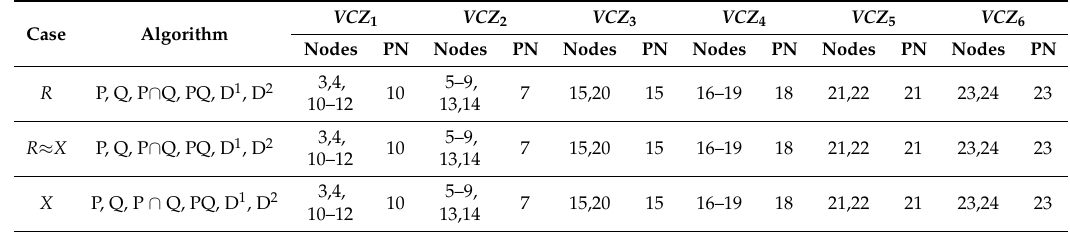
Table 6. Nodes and pilot nodes for six VCZs.